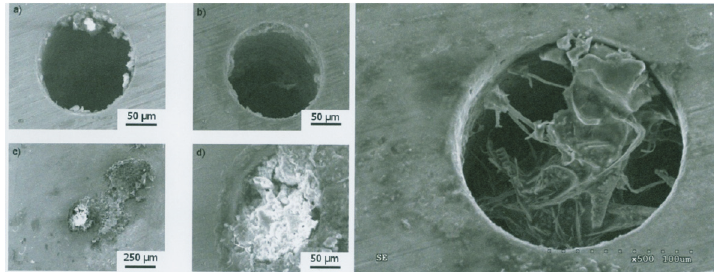
Fig. 4. View of the coking deposits formed around the edges and inside of the fuel spray holes in HPCR injection systems Rys. 4. Osady koksowe utworzone na obrzeżach i wewnątrz otworków wylotowych wtryskiwaczy układu